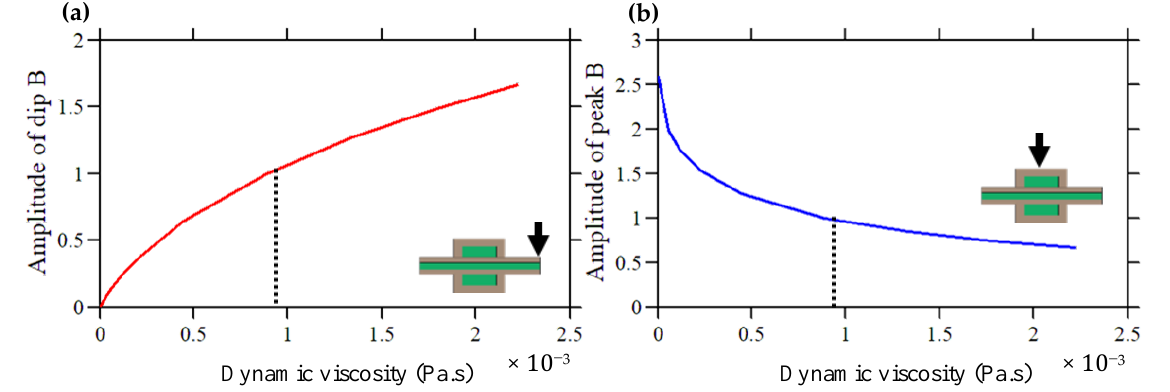
Figure 6. Amplitude of mode B of the washer as a function of the dynamic viscosity of the liquid, evaluated from ( a ) the transmission and ( b ) the surface of the washer. The dotted line indicates the value of the dynamic viscosity of the water ( µ = 8.9 × 10 − 4 Pa · s ) . The curves are normalized to their values at the water’s viscosity.